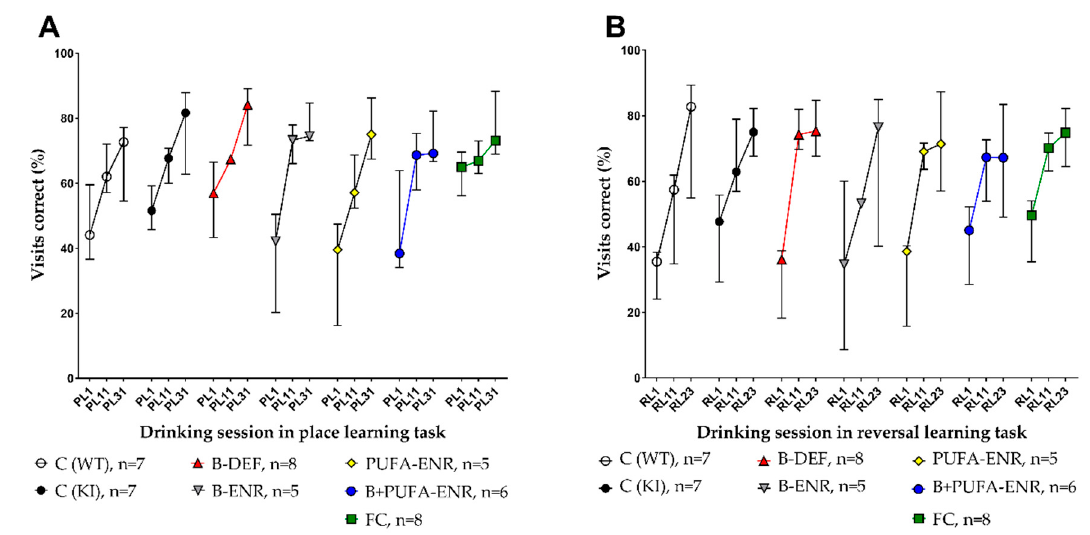
Figure 9. IntelliCage place learning (PL) and reversal learning (RL) task in 27–34 (incl. habituation period) weeks old C57BL/6J and App NL-G-F mice; 22–29 weeks on experimental diet; only females; data are shown for three points in time along the course of the task and presented as median ± IQR; outliers beyond threefold IQR removed; p < 0.05 (Mann-Whitney-U-test) considered statistically significant (*); test on statistical significance carried out for the final point in time. ( A ) Percentage of correct visits during drinking sessions in the PL. ( B ) Percentage of correct visits during drinking sessions in the RL.